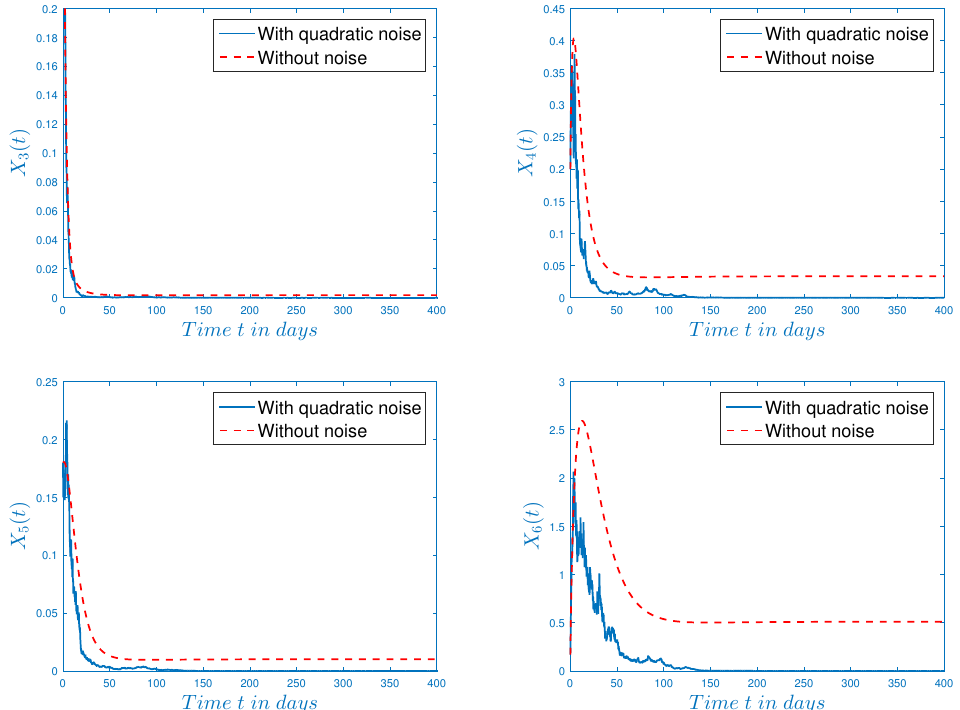
Figure 2. Numerical plot of the stochastic paths X k , k = 1,2,3,4,5,6 and their associated deterministic trajectories. The estimated deterministic values are selected from Table 2 and the stochastic amplitudes are chosen as follows: Ξ 1 (cid:96) = 0.07, Ξ 2 (cid:96) = 0.17, Ξ 3 (cid:96) = 0.1835, Ξ 4 (cid:96) = 0.764, Ξ 5 (cid:96) = 0.148, Ξ 6 (cid:96) = 0.141,